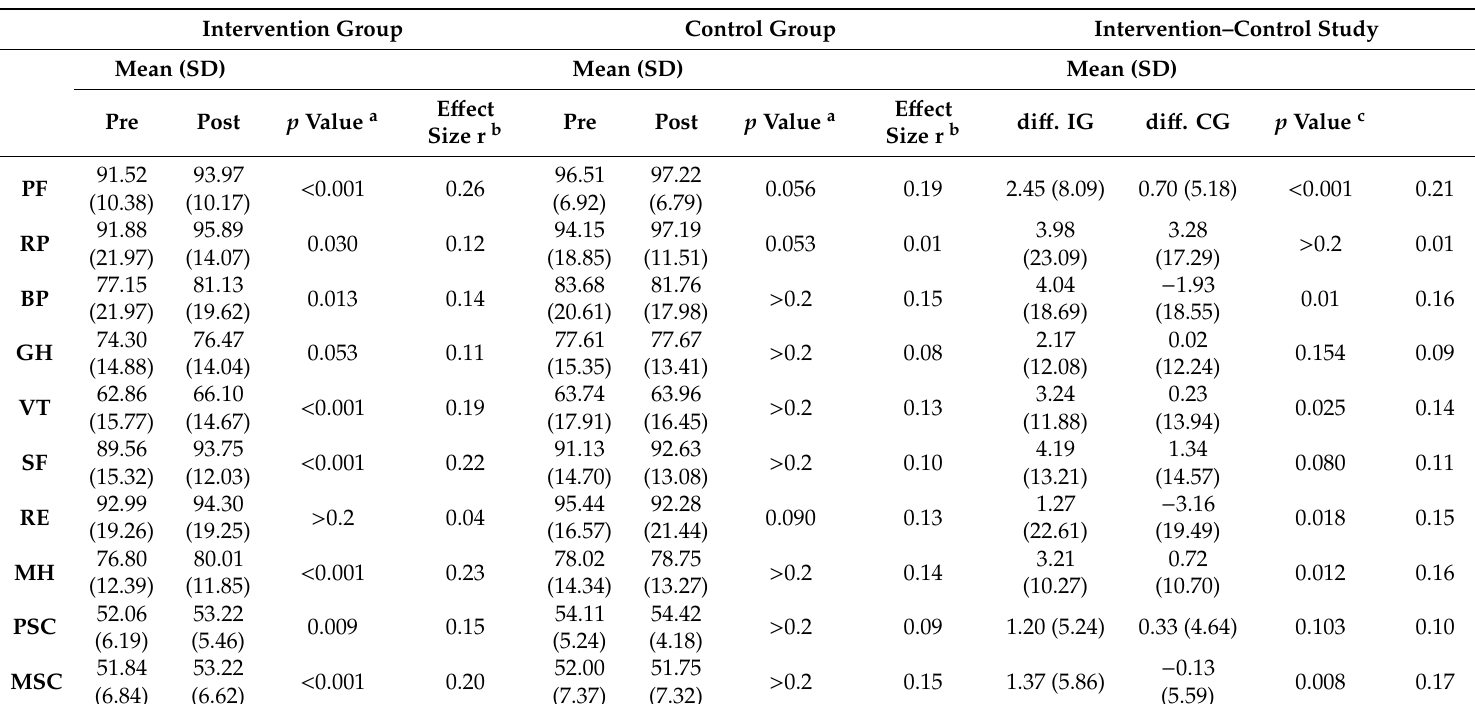
Table 3. SF-36 outcomes (mean, SD, p -value and e ff ect size) are shown for IG (pre–post), CG (pre–post) and intervention control study (pre–post di ff erences). Di ff . means di ff erence between post and baseline. Subscales: physical functioning (PF), role limitations due to physical problems (RP), bodily pain (BP), general health perceptions (GH), vitality (VT), social functioning (SF), role limitations due to emotional problems (RE), mental health (MH) and physical and mental health sum scores (PSC and MSC,